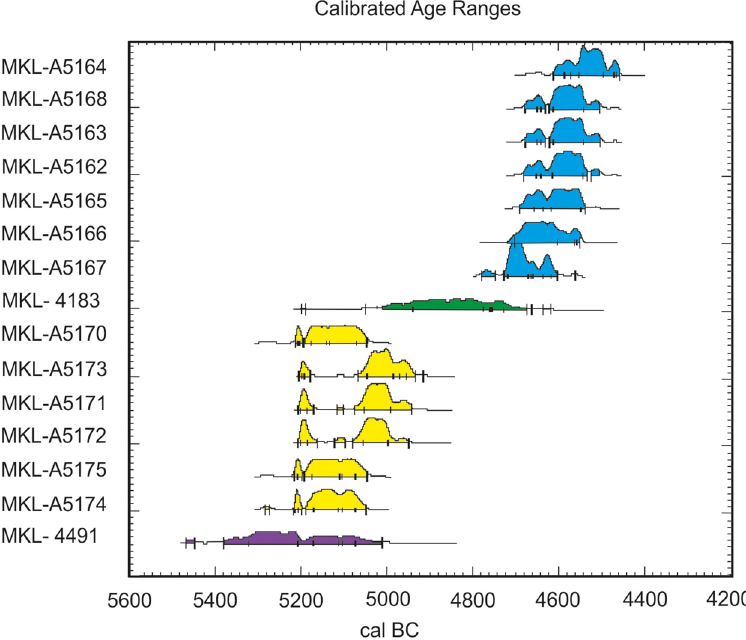
Figure 6: Radiocarbon chronology of Targowisko settlement region. The colors of probability distributions of 14C dates cor - respond to the LBK and MC chronological phases speci fi ed in the caption to Figure 2 ( acc. to Kadrow et al., 2022 )